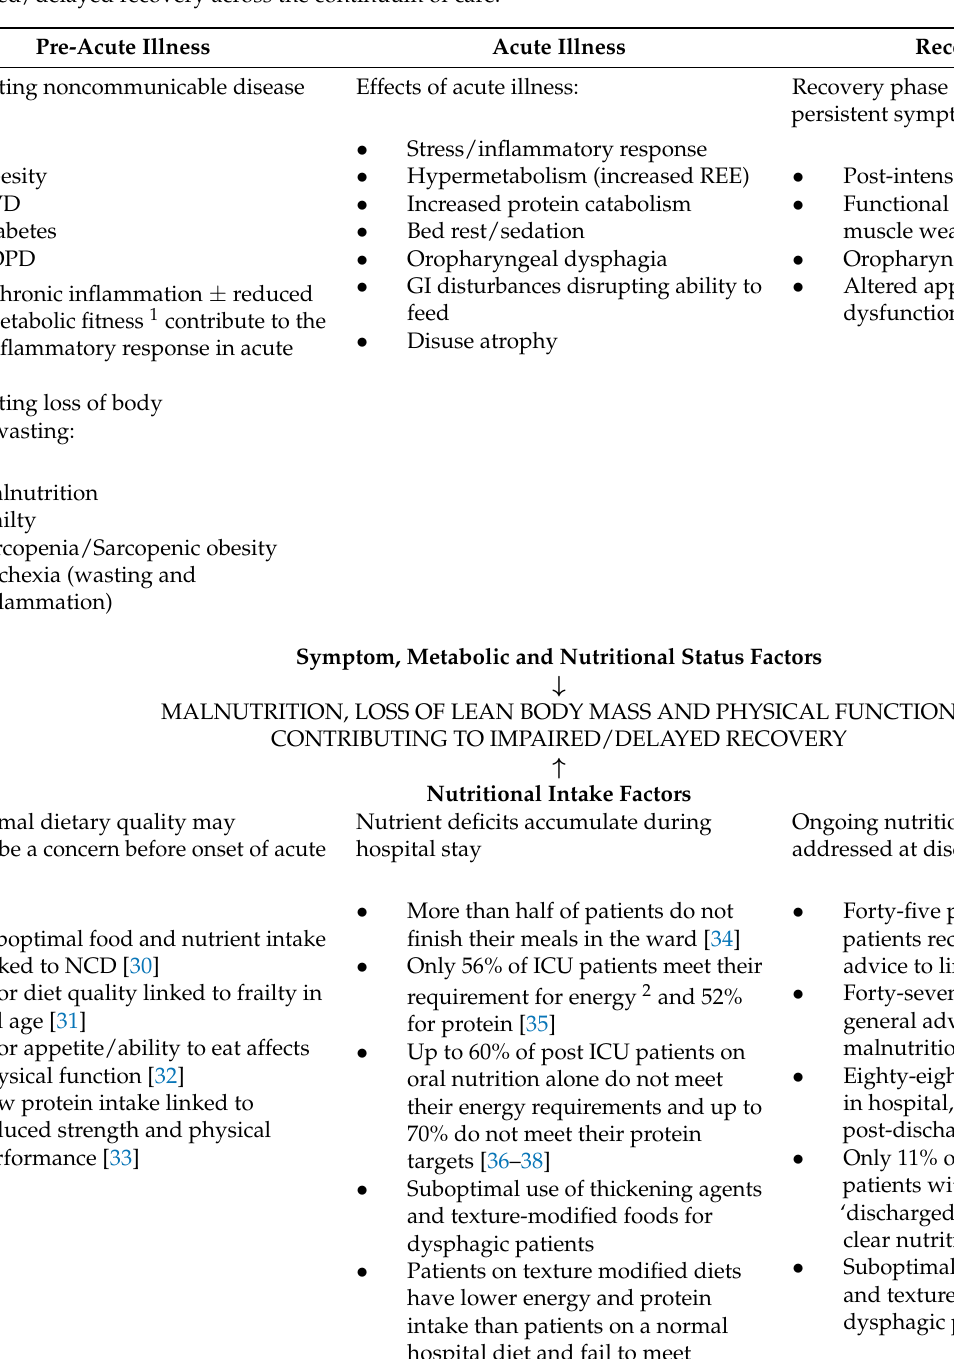
Table 1. Symptom, metabolic, nutritional status and nutritional intake factors contributing to malnutrition and im- paired/delayed recovery across the continuum of